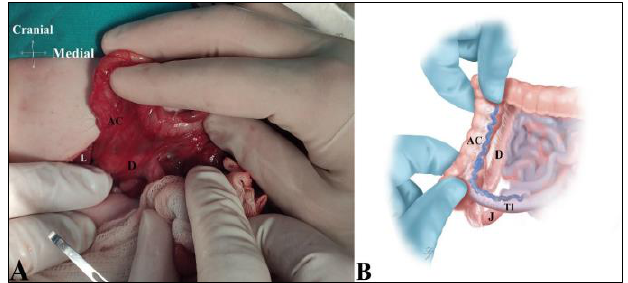
Figure 3: Anatomy of the duodenum within the retrocolic ''sac'': A) Original peroperative photo. B) Diagrammatic